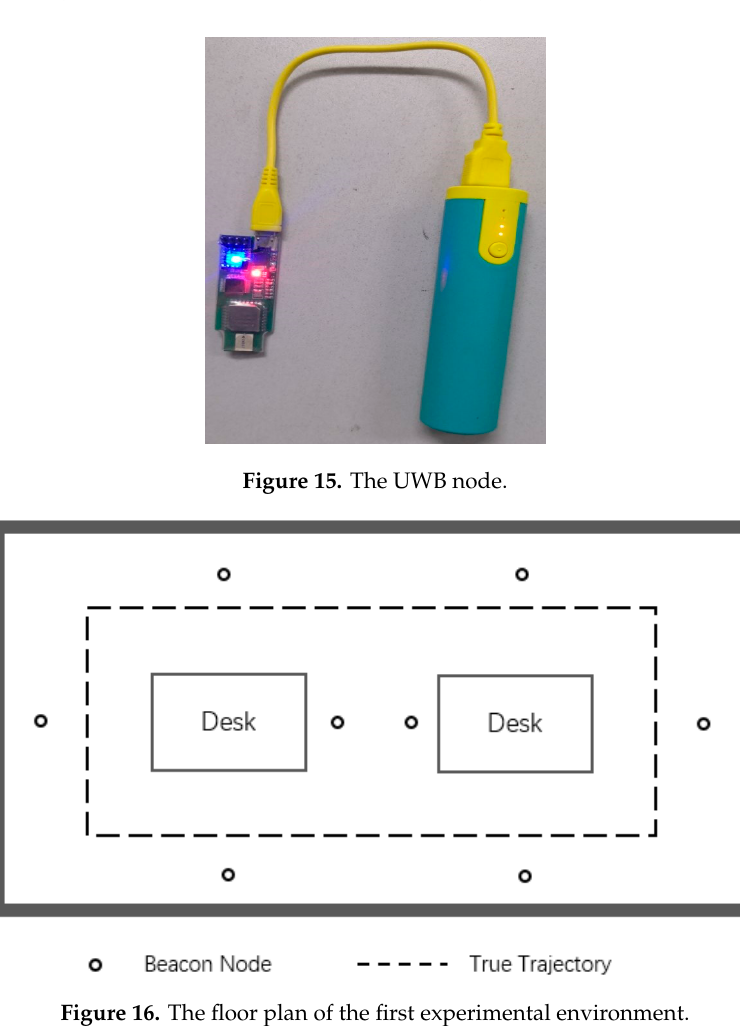
Figure 16. The floor plan of the first experimental environment.